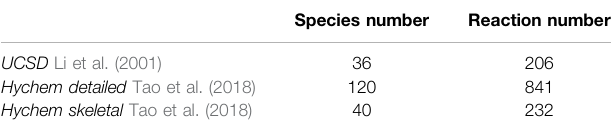
TABLE 4 | combustion kinetic mechanism used in the present